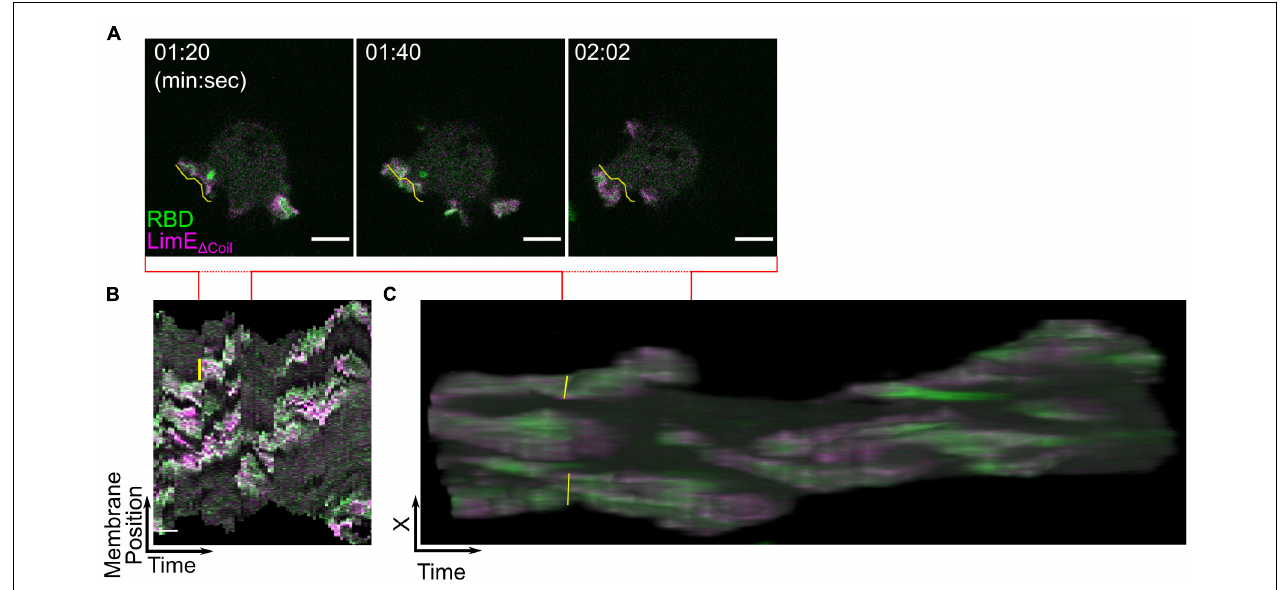
FIGURE 7 | Displaying biosensors on cell protrusions. ( A–C) Scanning confocal imaging (A) , membrane kymograph (B) , and t-stack (C) of Ras activation (RBD) and actin polymerization (LimE (cid:49) Coil ) in AX3 Dictyostelium cells. The yellow line highlights the same protrusion in all three images. Scale bars in panels (A) = 5 µ m and (B) = 30 s. t = 00:00 indicates the start of acquisition. Red lines indicate the span of time covered by the still images in panel (A)